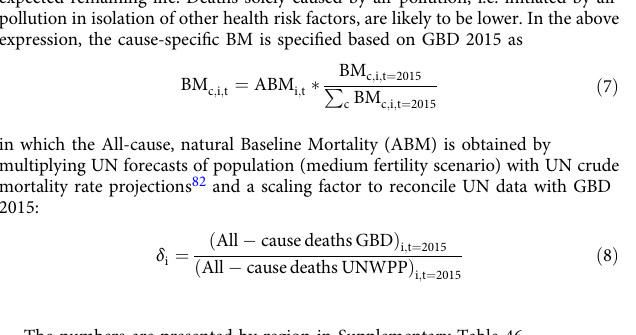
Table 45. In order to reduce artefacts associated with the downscaling and remapping of emissions between POLES-JRC and FASST regions, impacts are aggregated to the regional scale. Population-weighted regional pollutant exposure is obtained by interpolating TM5-FASST 1°×1° pollution grid maps to 0.5°×0.5° and overlaying them with SSP gridded population maps at the same resolution for the corresponding scenario year 81 . The regional population-weighted exposure to pollutant P is then obtained as P ð 3 P pop ¼